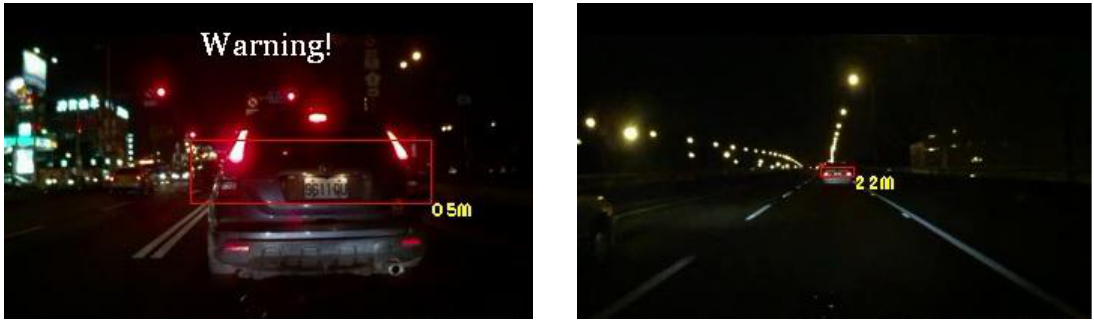
Figure 22. Results of vehicle detection and event determination for a nighttime urban road under bright illumination and free-flowing traffic conditions (Test video